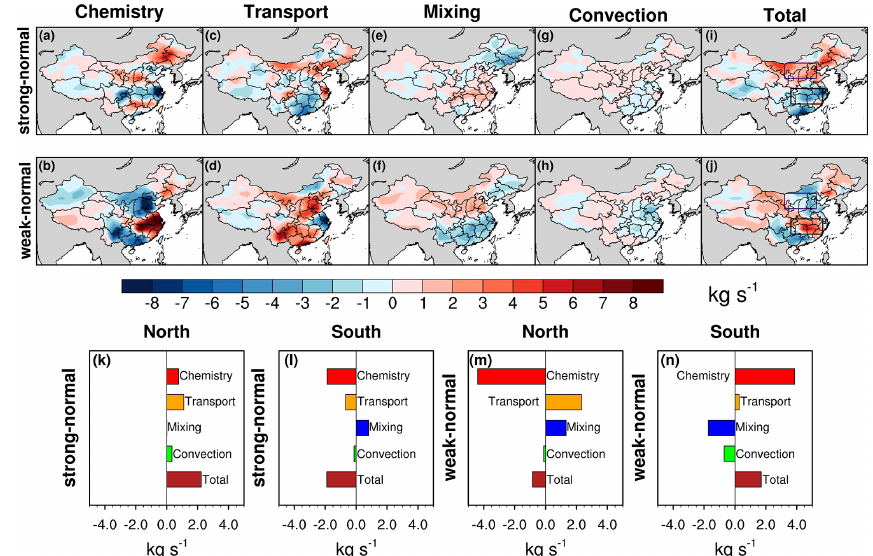
Figure 4. The budget diagnostics (kgs − 1 ) including chemistry, transport, mixing, and convection in the GEOS-Chem model. (a–j) The first row shows the differences between strong and normal WPSH days and the second row shows the differences between weak and normal WPSH days. (k–n) The area-averaged budget diagnostics (kgs − 1 ) for a northern (36.0–42.0 ◦ N, 105.0–117.5 ◦ E) and a southern (26.0– 32.0 ◦ N, 107.5–120.0 ◦ E) region (purple and black boxes in i and j ).